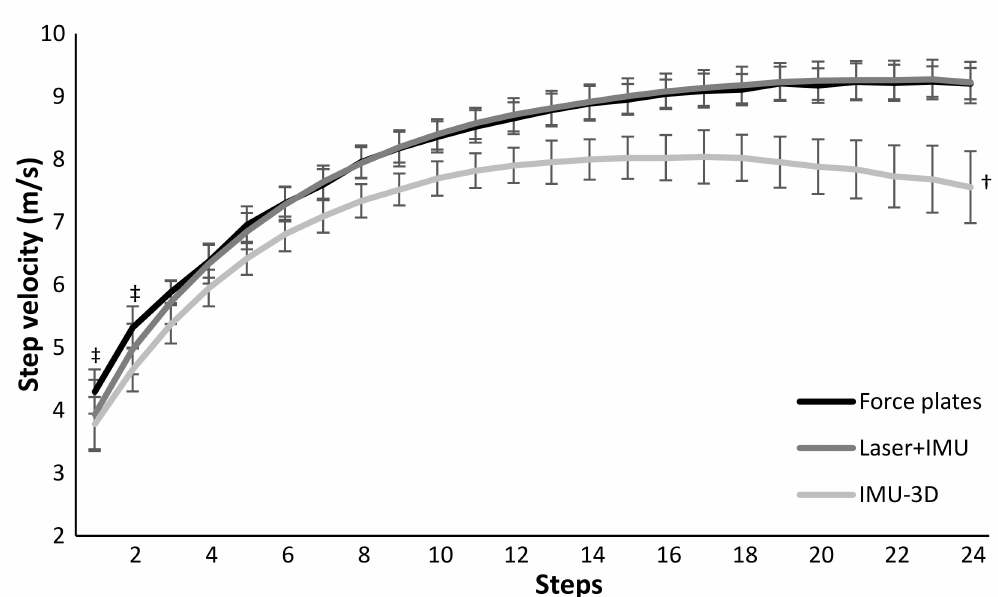
Figure 2. Mean ( ± SD) step-by-step velocity averaged over all participants during 50 m sprints measured with force plates, laser+IMU and IMU-3D based systems. † indicates a significant difference for each step for this condition with the force plate condition on a p < 0.05 level. ‡ indicates a significant difference for this step for laser+IMU system with the force plate condition on a p < 0.05